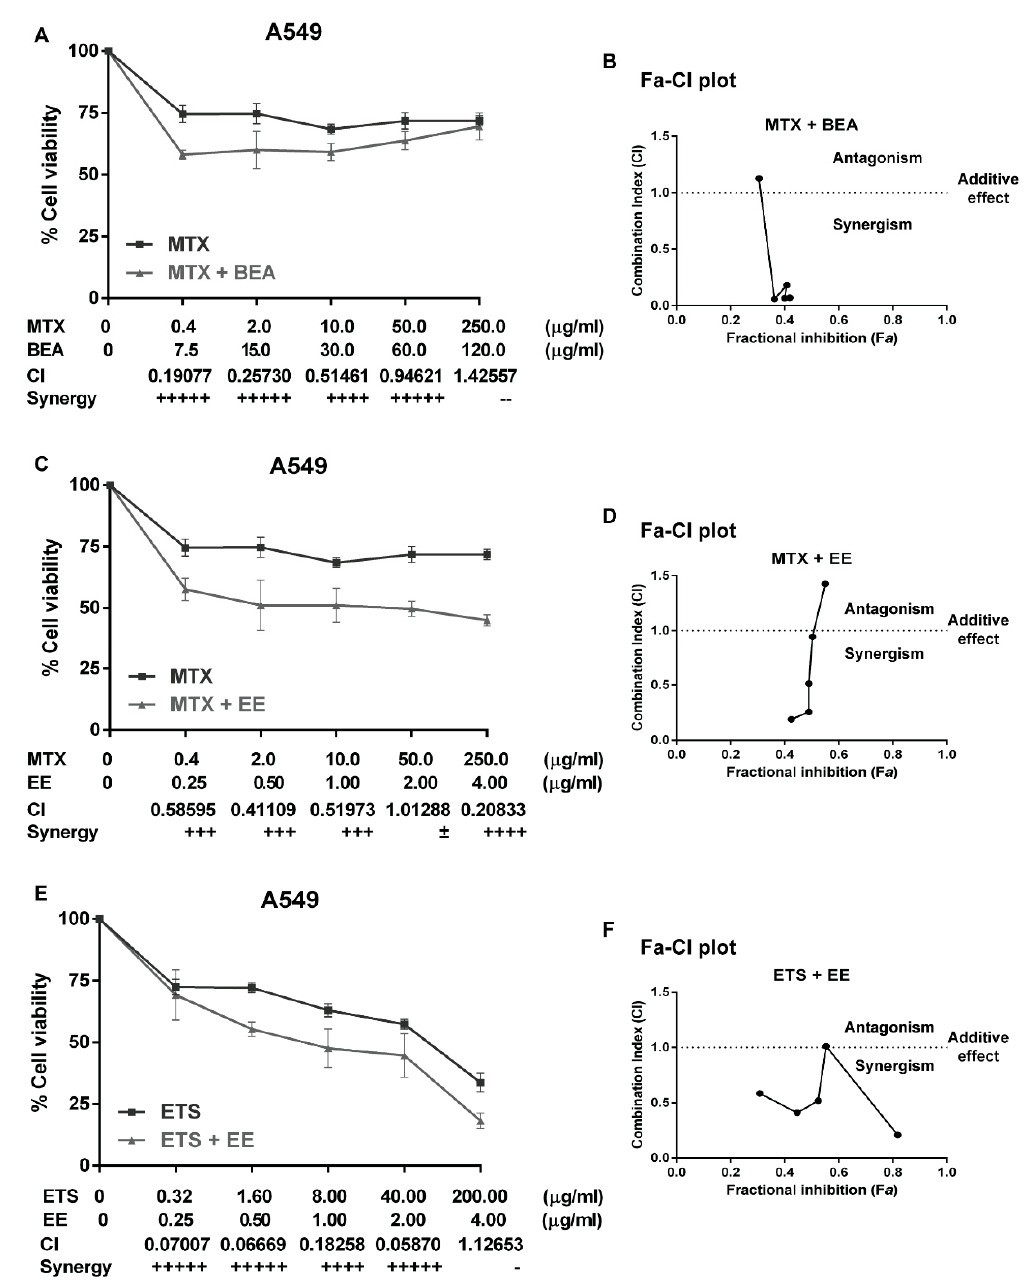
Figure 4. The synergistic combination of chemotherapy drugs with the effective extracts against A549 cells. ( A , C , E ) The cytotoxicity plots show the percentage of cell viability of A549 cells on the Y -axis. The cells were treated with MTX or ETS alone, and combination of MTX + BEA, MTX + EE, and ETS + EE. The concentration of MTX, ETS, BEA, and EE were indicated at the X -axis which also showed CI values and their synergy interpretation of each combined concentration. The explanation of the synergy level and symbol are showed in the Table 6. The data are reported as mean ± SD of three independent experiments and was carried out in triplicate. ( B , D , F ) The combination index (CI) plots correspond to the cell viabilities of each combination and were interpreted by CompuSyn software analysis.